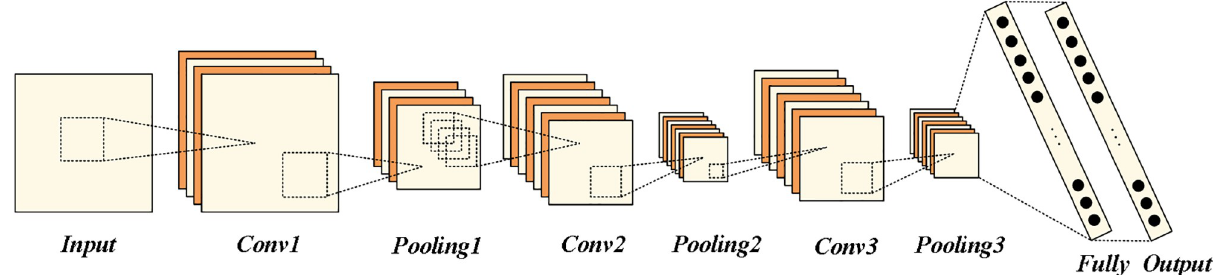
Fig 6. The structure diagram of the modified MS-CNN